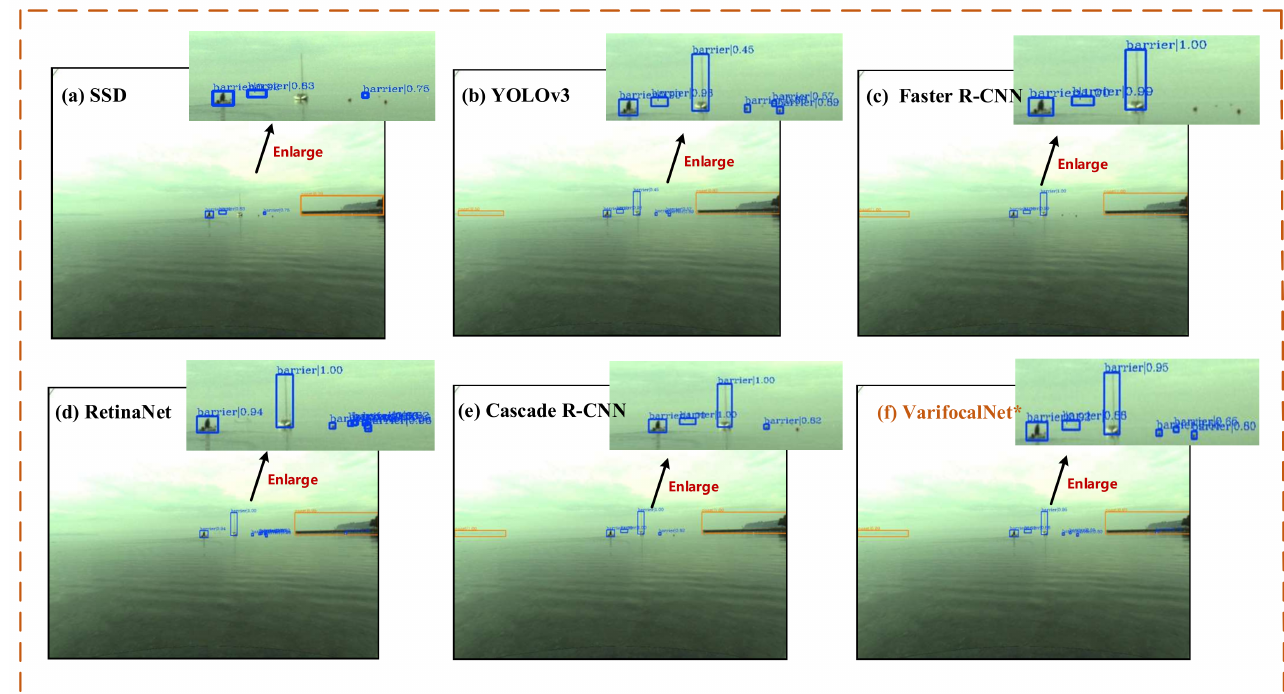
Figure 14. The visual comparisons of different competing methods for detection of sea-surface obstacles under sea fog environment. In ( a – c , e ), the SSD, YOLOv3, Faster R-CNN, and Cascade R-CNN have varying degrees of missed detection, and the RetinaNet generates many false detection results, as shown in ( d ). In contrast, our method is able to achieve more satisfactory detection performance, as shown in ( f